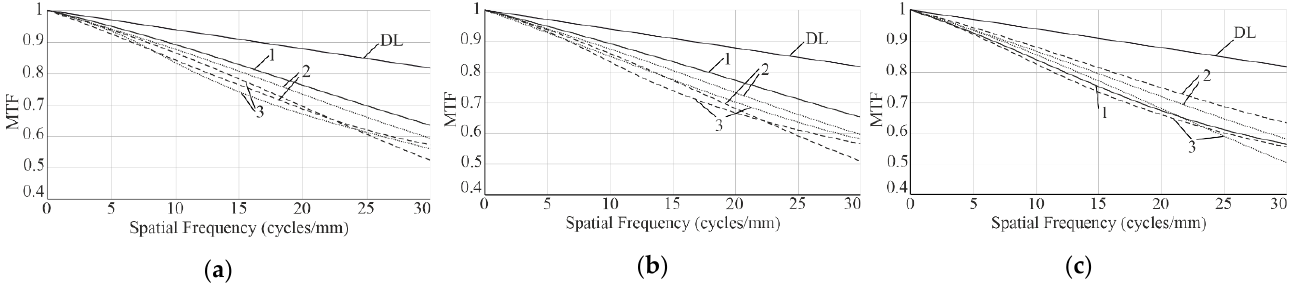
Figure 7. Polychromatic diffraction MTF for the refractive-diffractive version of the objective: ( a ), at − 40 °C; ( b ), at 20 °C; ( c ), at +60 °C. Curved lines DL, Diffraction Limit; 1, at 0°; 2, at 5° half-field angle; and 3, at 9.75° half-field angle (short-dashed curves, sagittal, and long-dashed curves, tangential responses).